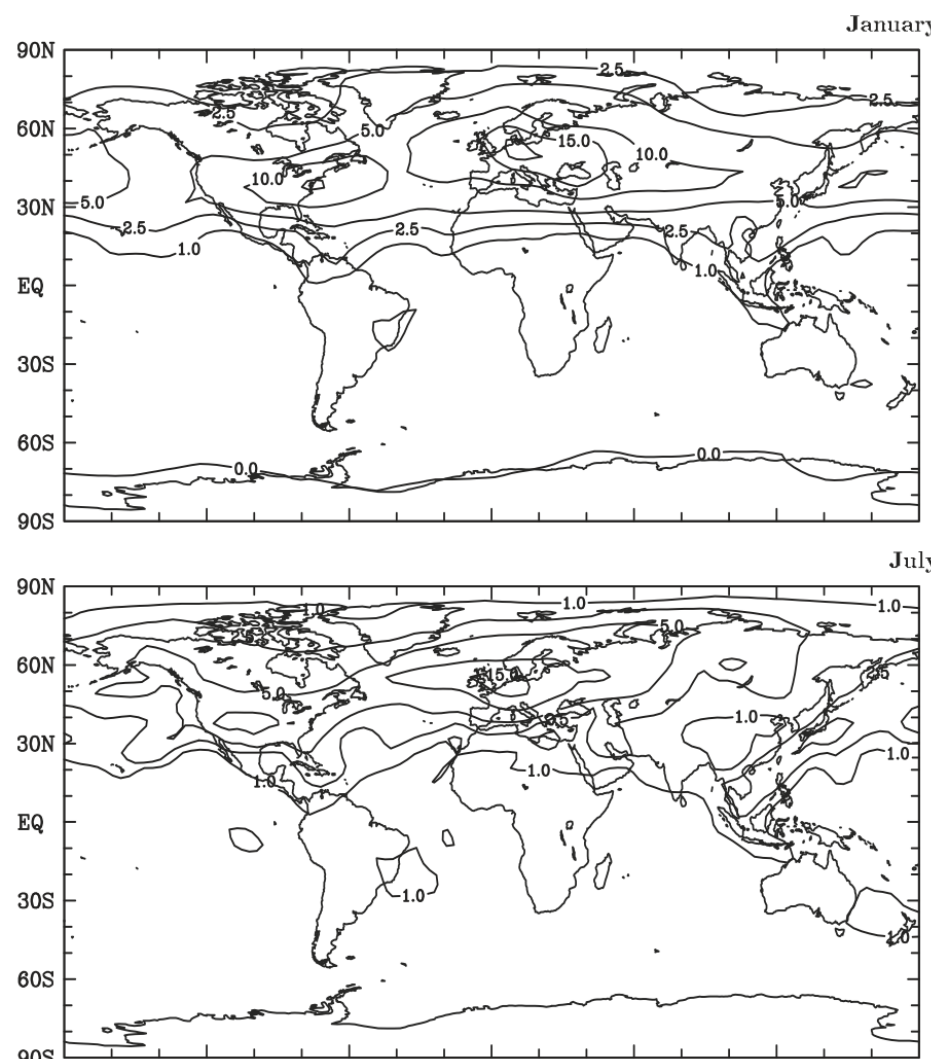
Fig. 21. Absolute decreases in aircraft-induced NO x (inpptv) in January (top) and July (bottom) at 250hPa due to plume effects. Reprinted from Kraabøl et al. (2002). An edited version of this paper was published by AGU. Copyright (2002) American Geophysical